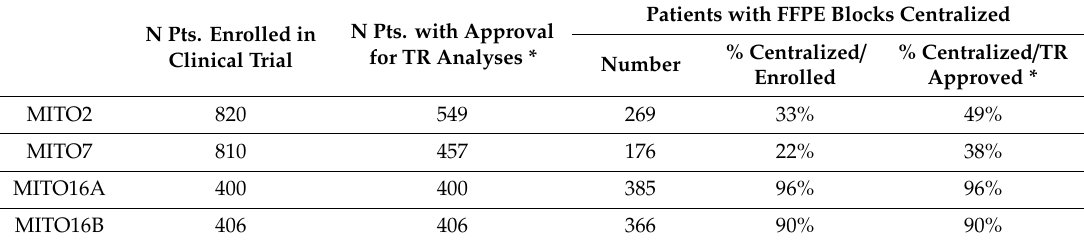
Table 2. FFPE samples centralized from MITO clinical trials.